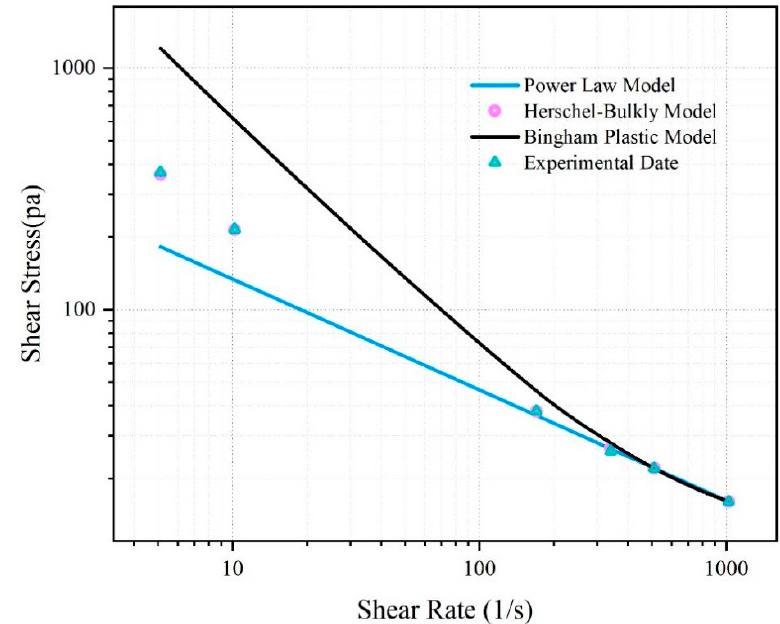
Figure 6. Rheological model of shear rate and viscosity of the SNV–Bent gel system .